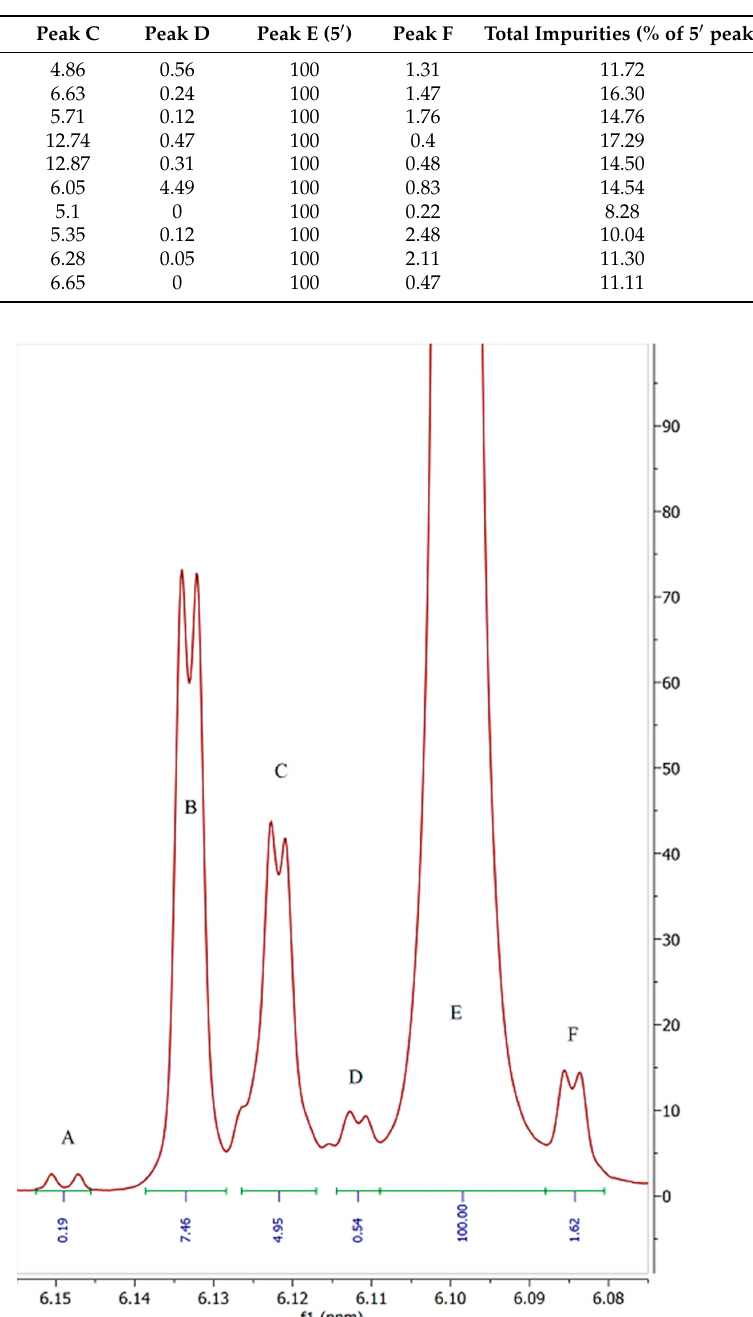
Table 1. Table of impurity integrals relative to the 5 (cid:48) proton “E” (Figures 2 and 3). 5 (cid:48) proton integral calibrated to 100.